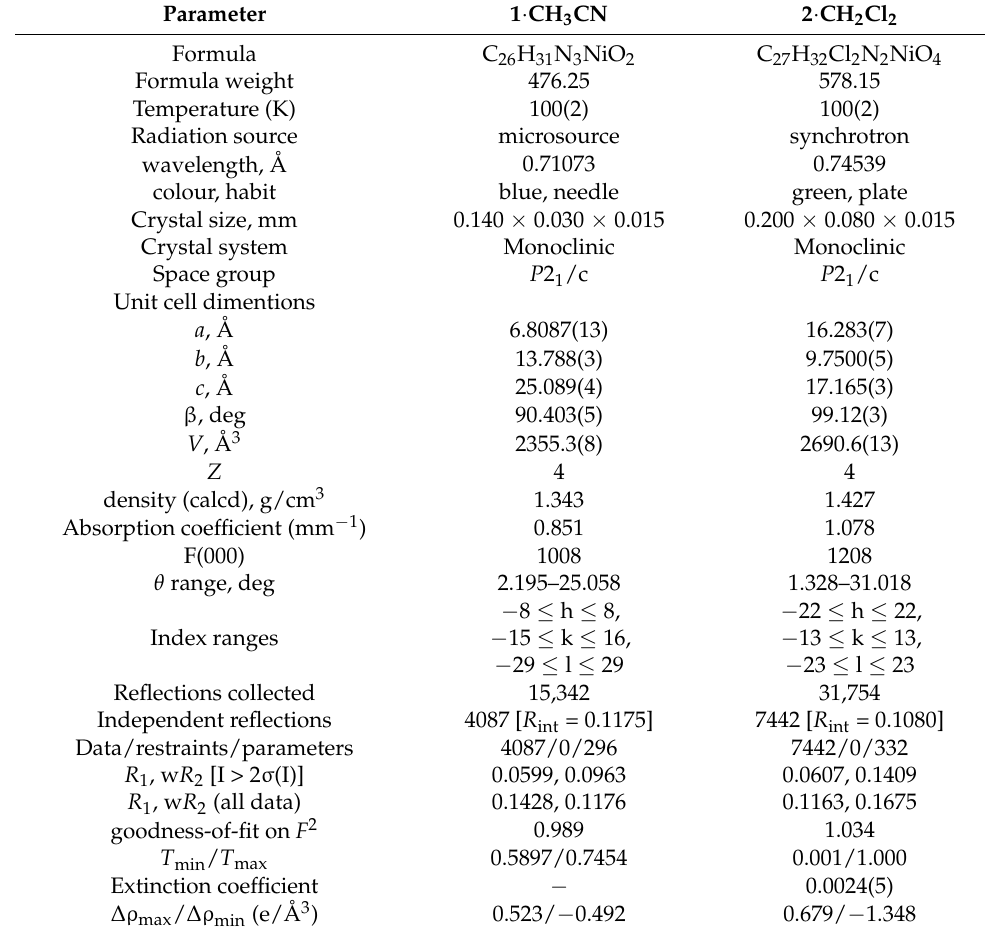
Table 4. X-ray crystallographic data and structure refinement for 1 and 2